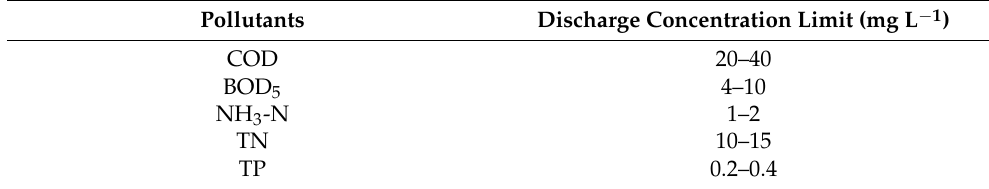
Table 1. Discharge concentration limit (mg L − 1 ) of water pollutants specified in the wastewater discharge standard for the Daqing River Basin (DB